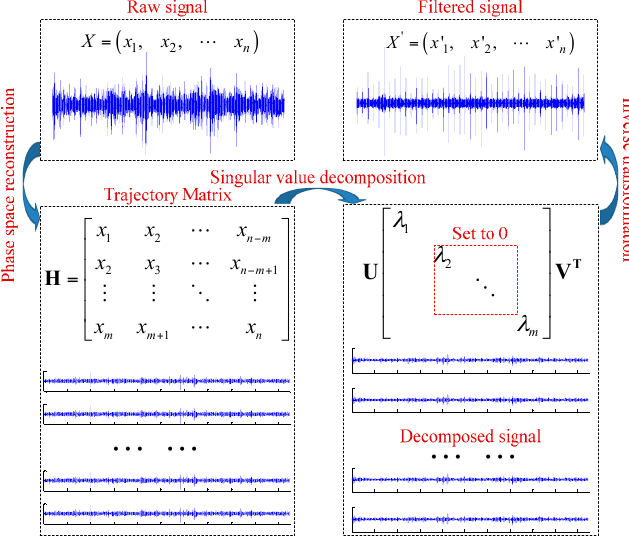
Figure 1. Singular spectrum analysis filtering schematic diagram.